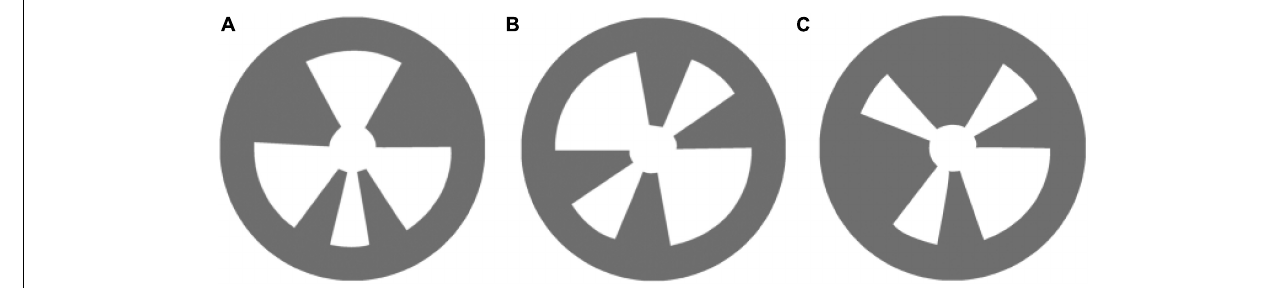
were affixed at the corners of the maze. Three marks